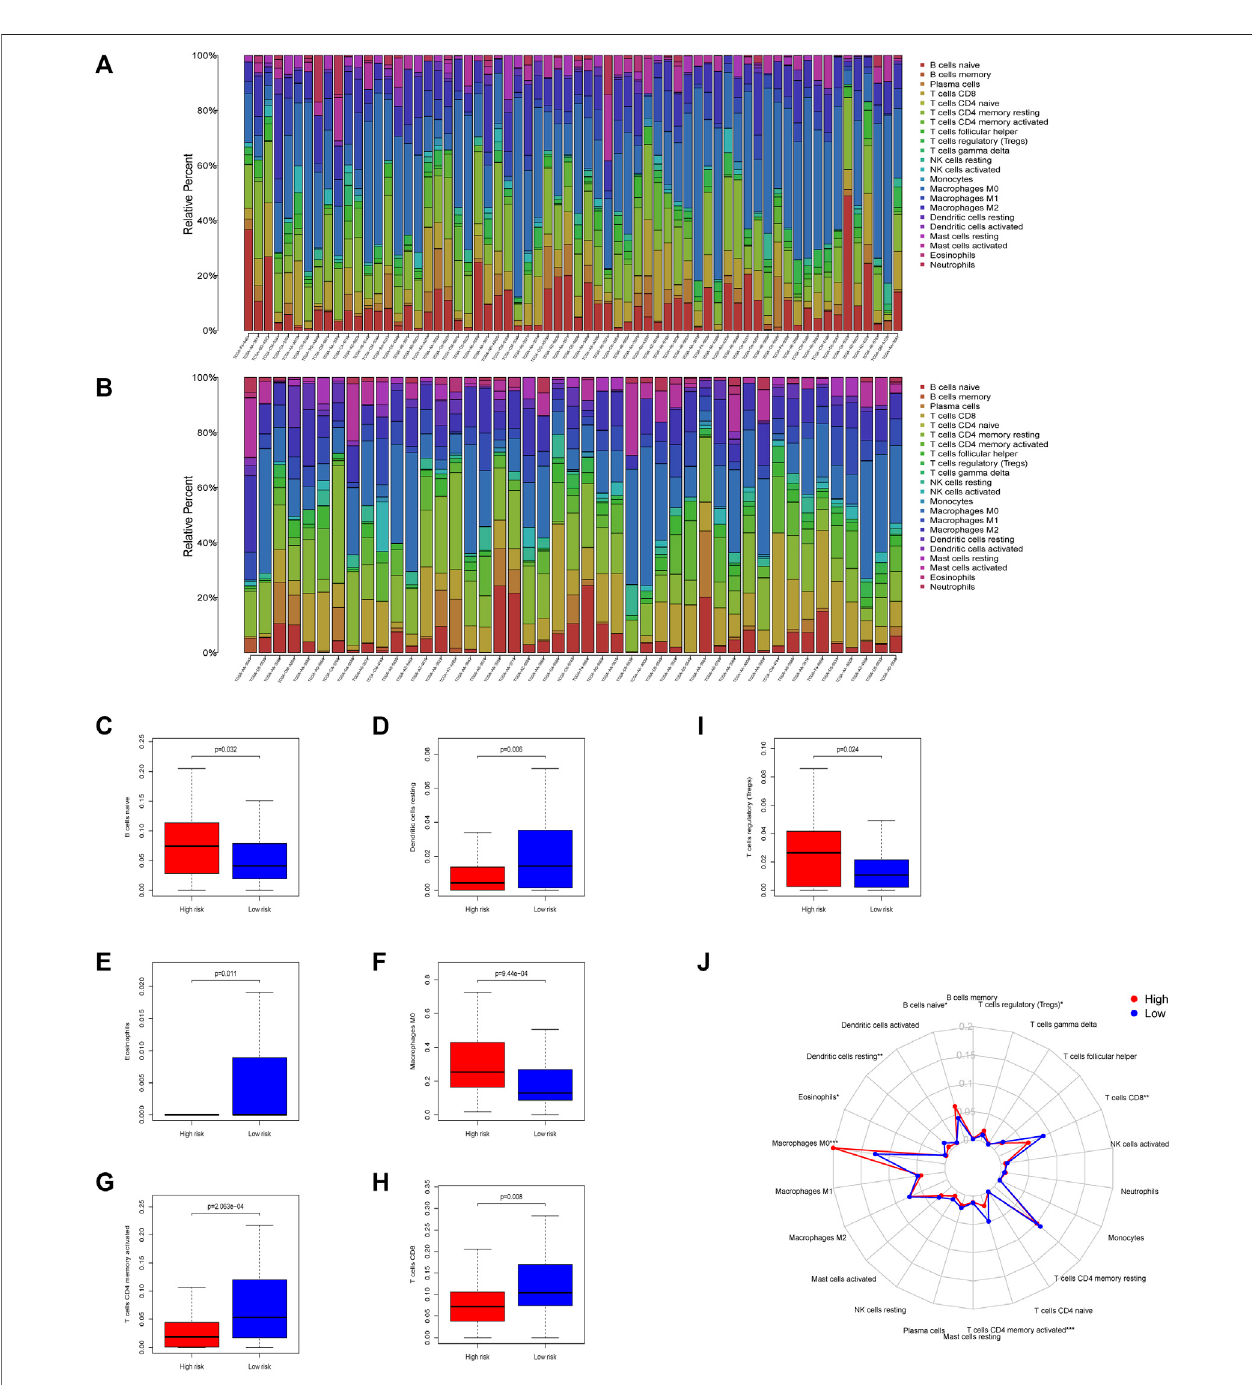
FIGURE 6 | Immune in fi ltration conditions between the two mtDNA-related groups in colon carcinoma samples. Immune in fi ltration of high- (A) and low- (B) risk group calculated usingtheCIBERSORT algorithmwasshowninthetwobarplot,respectively. (C – I) Differencesoftumor-in fi ltratingimmunecellsduringthetwogroups. Seven subtypes of tumor-in fi ltrating immune cells between the high-risk and low-risk group showed signi fi cant differences ( p < 0.05). (J) Radar plot shows the whole survey of CIBERSORT analysis (*: p < 0.05 **: p < 0.01 ***: and p < 0.001).